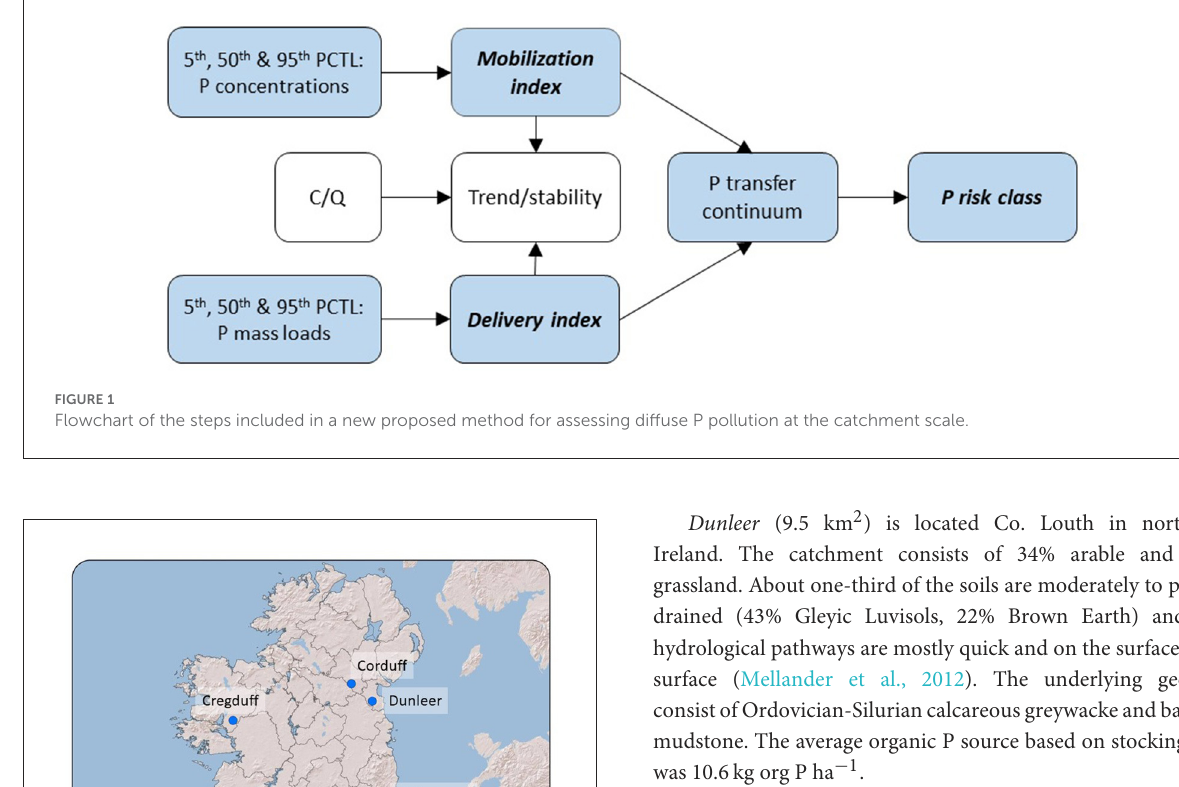
was 20.8 kg org P ha − 1